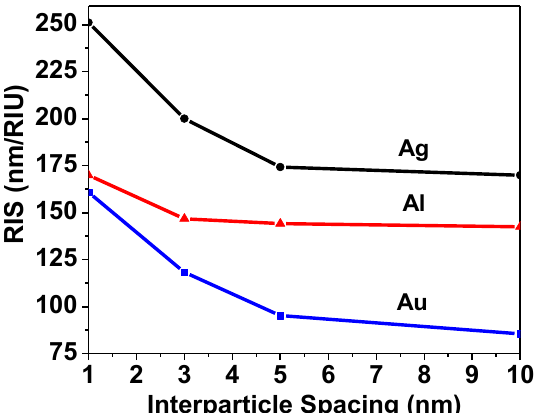
Figure 8: The interparticle spacing dependent refractive index sensitivity of Au, Ag and Al homo- dimer nanostructure. The particle size is 20